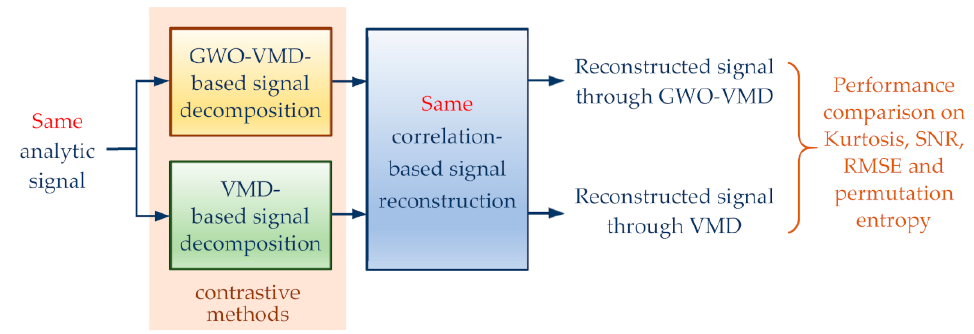
Figure 2. Contrast experiments of GWO-VMD-based and VMD-based signal decomposition. The waveforms of the experimental signals and their spectra are shown in Figure 3; the envelope spectra of s ( t ) and x ( t ) are shown in Figure 4.